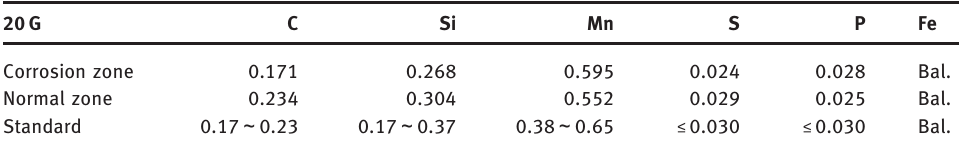
Table 1: The compositions of the normal and corrosion zone of 20G steel.  G